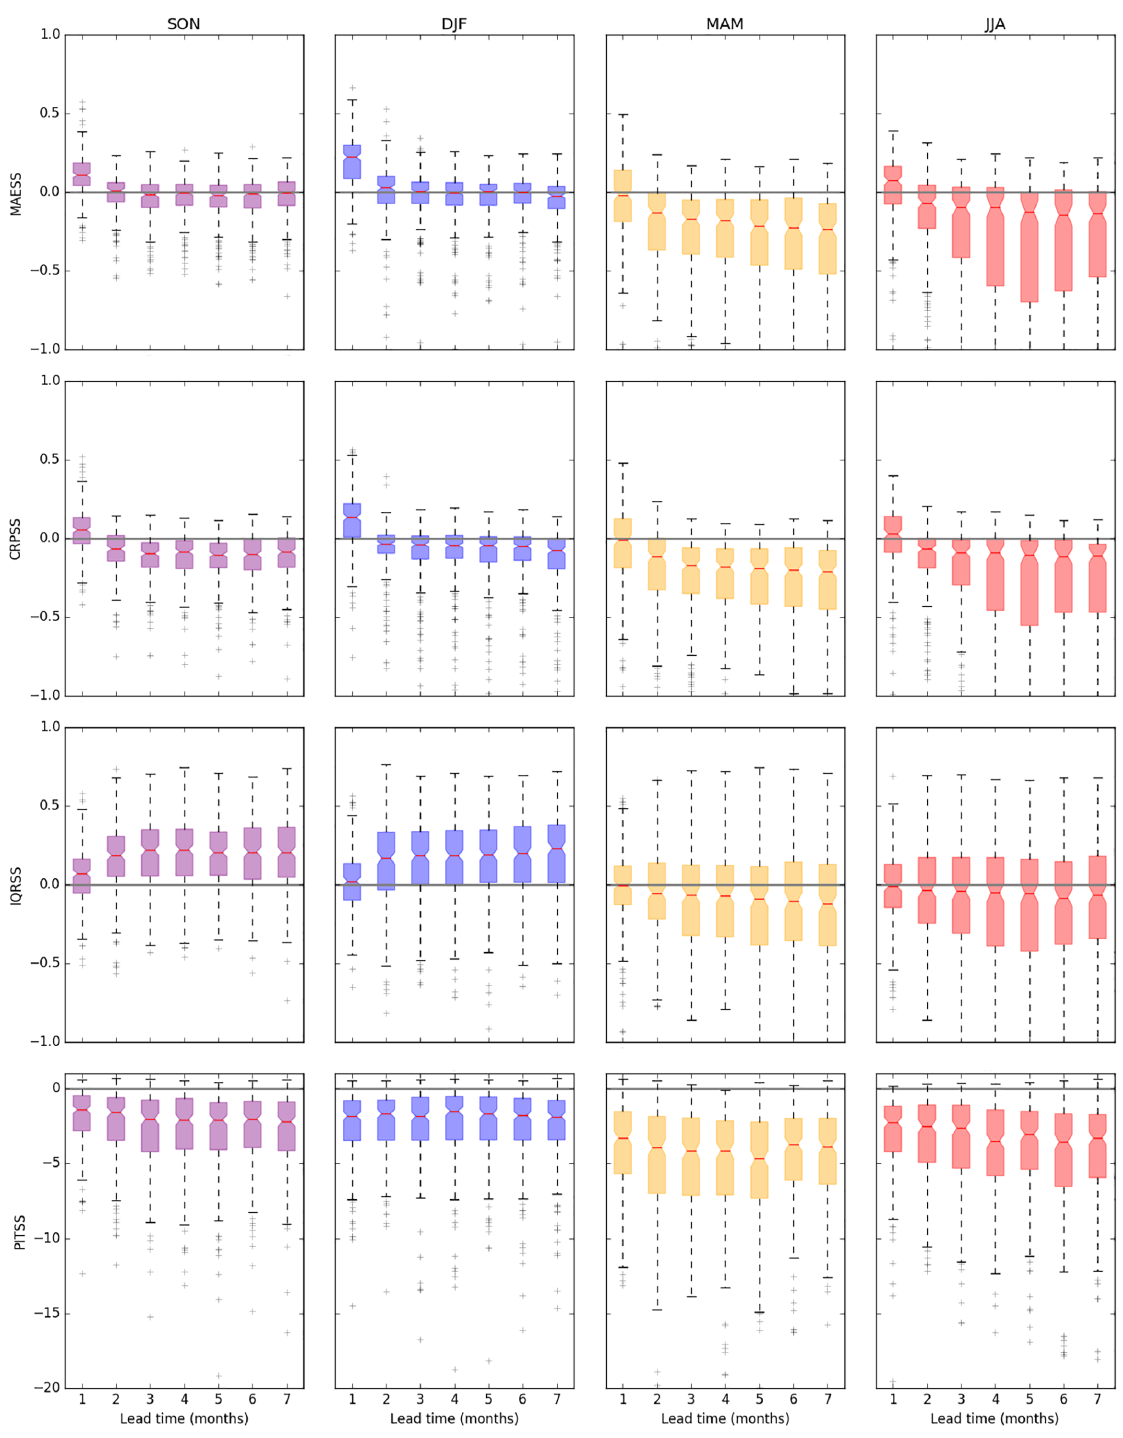
Figure 3. Boxplots of the MAESS, CRPSS, IQRSS and PITSS (from the top to bottom rows) for all four seasons (SON, DJF, MAM and JJA from the left-most to right-most columns) as a function of lead time (i.e. 1 to 7 months). The boxplots contain the scores for all target months falling in a given season and all 74 European regions. For all scores, values larger (smaller) than zero indicate that the CM-SSF is more (less) skilful than the ESP (benchmark). Where the skill is zero, the CM-SSF is as skilful as the ESP for the hindcast period. Note that the PITSS plots have a different y -axis